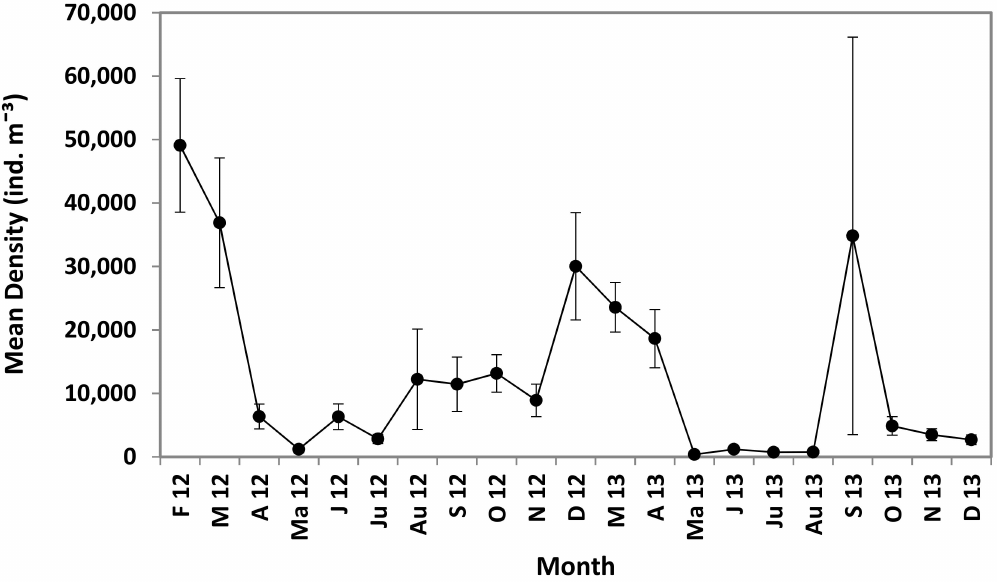
Figure 3. Temporal pattern in the abundance ( ± SE) of mesozooplankton in the Maryland Coastal Bays. Table 2. Seasonal average densities (ind. m − 3 ) of mesozooplankton in the Maryland Coastal Bays.